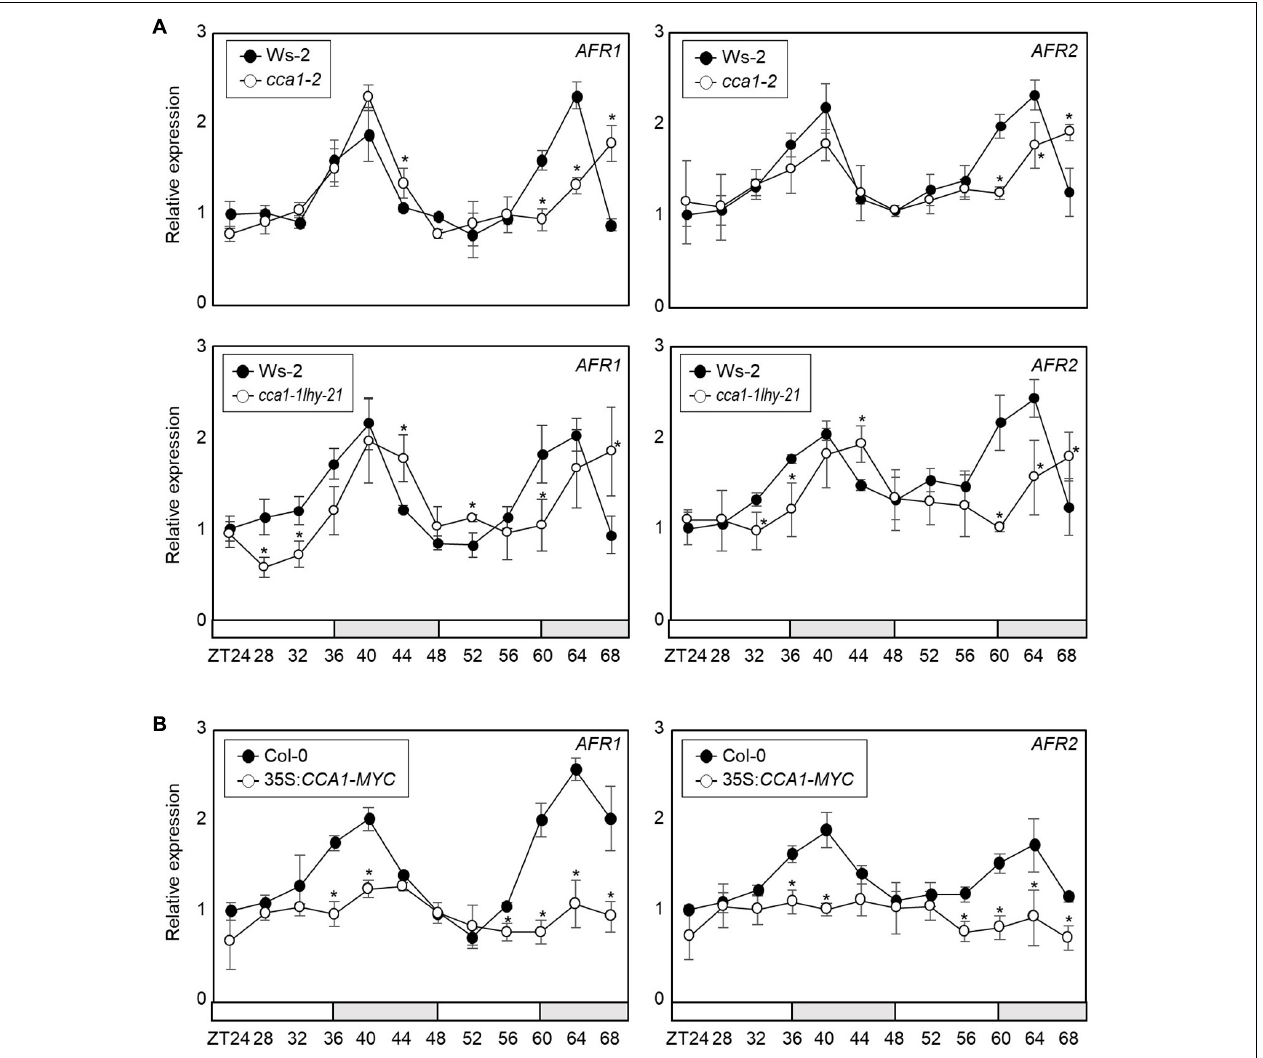
FIGURE 3 | Circadian expression of AFR s in CCA1 -misexpressing plants. In (A,B) , seedlings grown under ND conditions for 2 weeks were transferred to LL conditions at ZT0. Whole seedlings were harvested from ZT24 to ZT68 to analyze transcript accumulation. Transcript levels were determined by RT-qPCR. Gene expression values were normalized to eIF4A expression. Three independent biological replicates were averaged, and statistically significant differences (Student’s t -test, ∗ P < 0.05) are indicated by asterisks. Bars represent the standard error of the mean. The white and gray boxes indicate the subjective day and night, respectively. (A) Expression of AFR s in the cca1-2 and cca1-1lhy-21 mutant. (B) Expression of AFR s in 35S: CCA1-MYC transgenic